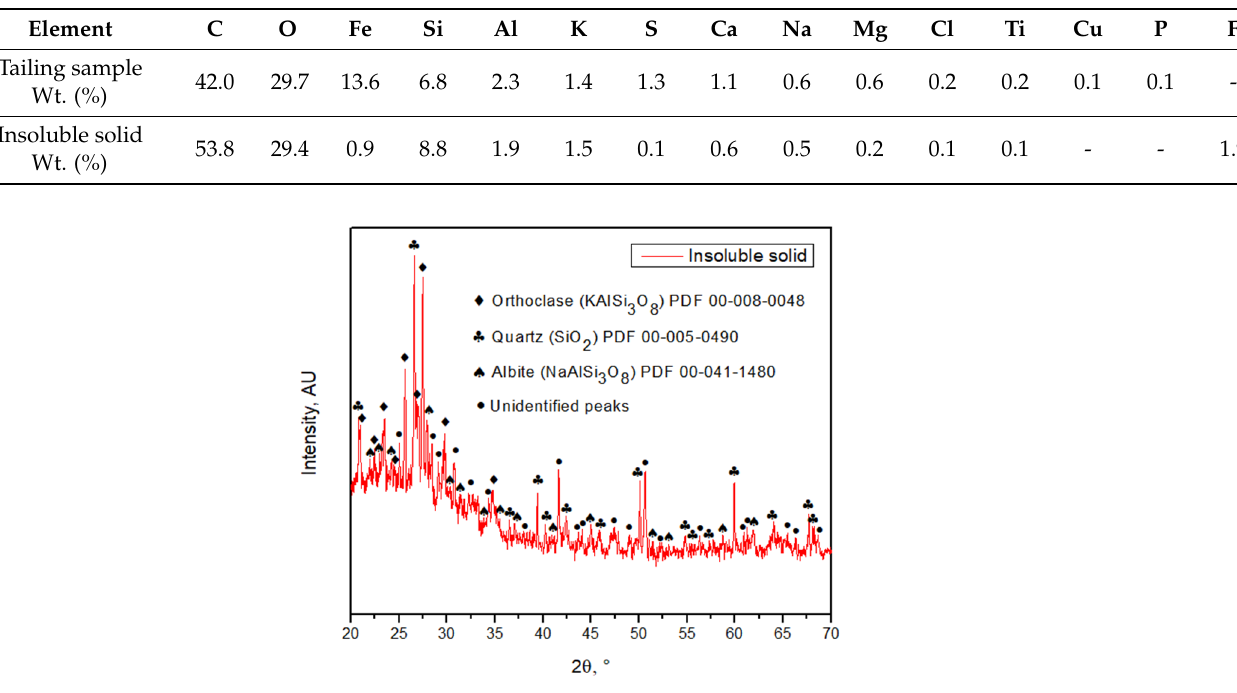
Figure 7. XRD diffractogram of an insoluble solid